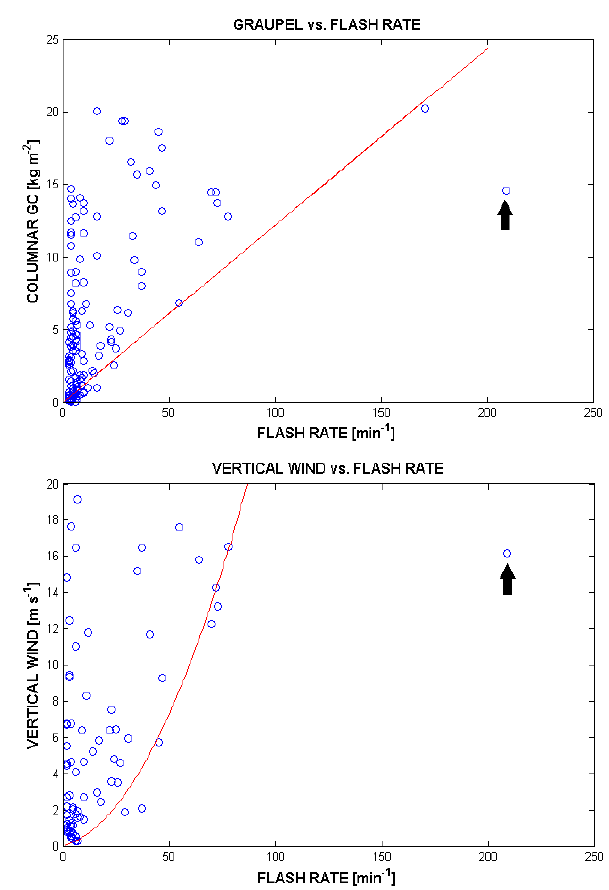
Fig. 16. Scatterplots of graupel columnar ice water content (top panel) and of vertical wind at the base of the charging zone (bot- tom panel) vs. total flash rate (IC + CG) sampled every minute. The red lines represent the minimum-threshold regression curves of Ta- ble 2.